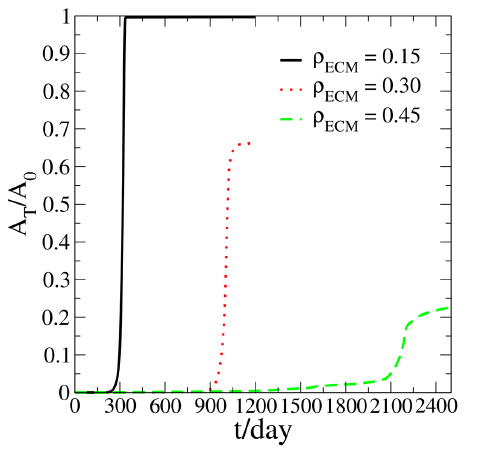
Figure 5. Simulated tumor area A T normalized by the area A 0 of the growth permitting region of a noninvasive tumor growing in the ECM with different (cid:2) rr ECM .